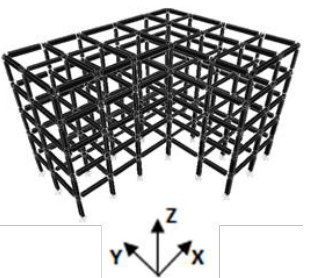
Figure 3. Numerical model of a building that has an irregular plan with 5 floors.